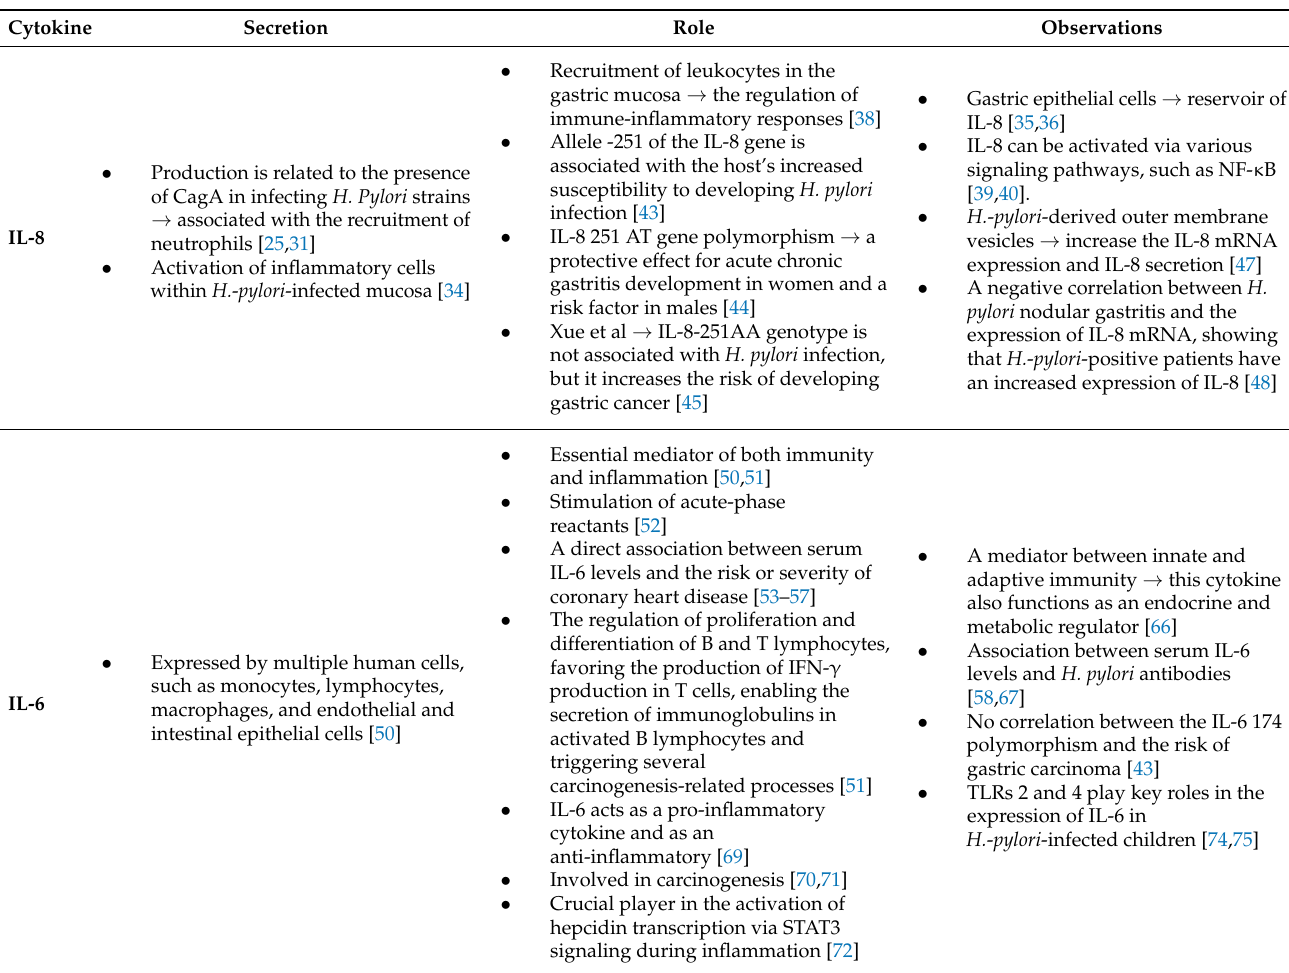
Table 1. The role of cytokines in inflammation and H. pylori